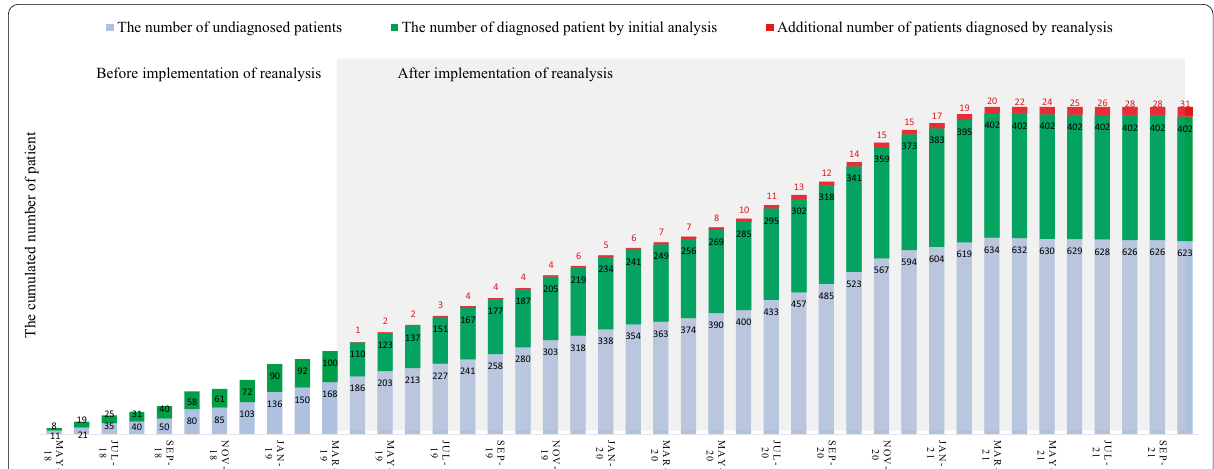
Fig. 2 The cumulative monthly number of undiagnosed patients (light blue), patients diagnosed by the initial analysis (green) and by